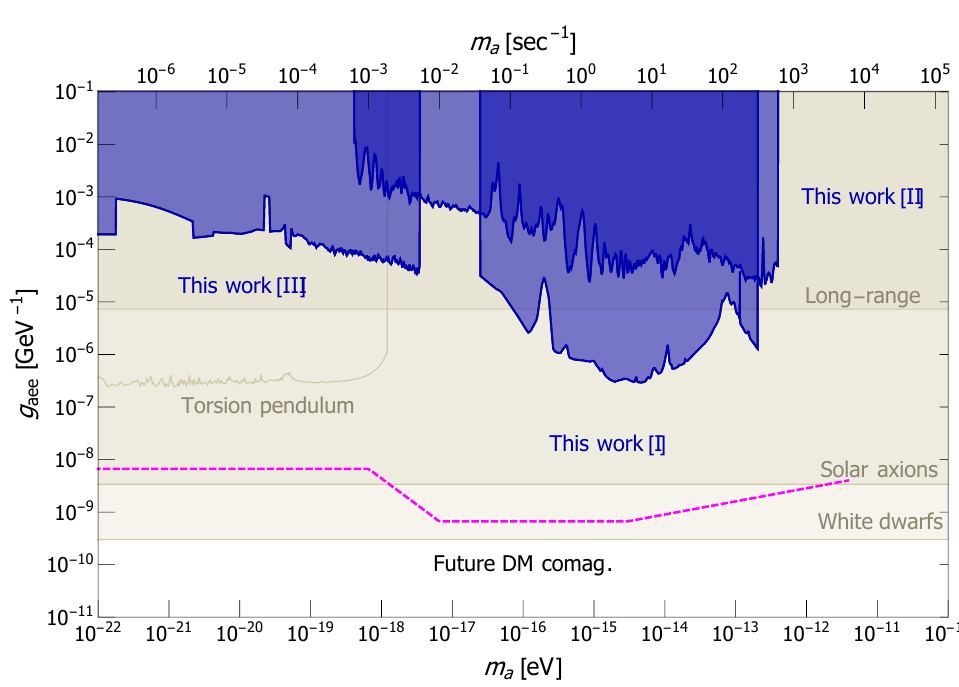
Figure 4 . Constraints and projected reach for ALP-electron couplings. The shaded blue regions represent the 95% C.L. bounds derived in this paper from datasets I [47], II [48] and III [49], the third of which continue to arbitrarily small ALP masses. The sudden increase of the bound at ultra-light masses is due to longer measurement-time being available at those masses, and not an increased sensitivity at low frequencies. The shaded ‘long-range’ region represents the constraint from searching for new long range interactions [40]. The ‘Torsion-Pendulum’ region represents the bound from the search for the anomalous (cid:12)eld sourced by ALPs, interacting with polarized electrons of a so called \spin-pendulum" [35]. The shaded ‘solar axions’ region is excluded by the solar axion search of the LUX collaboration [66]. The shaded ‘white dwarfs’ region is excluded by considering the e(cid:11)ects axions would have on white dwarfs as a new cooling mechanism [67]. The magenta dashed curve describes the future reach of an improved comagnetometer setup we propose; see main text for further